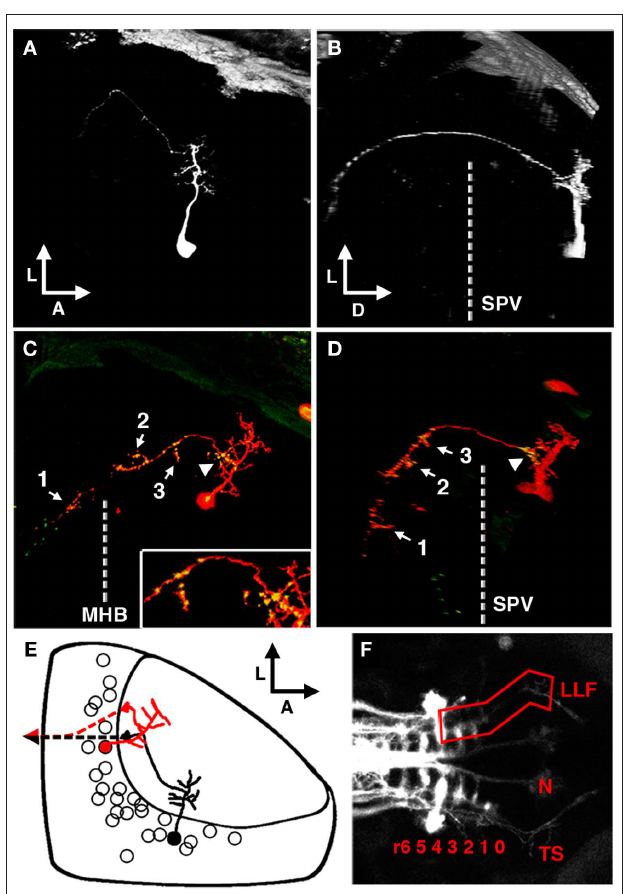
FiGure 8 | The periventricular projection neuron cell type. (A) Dorsal view of a two-photon image volume containing a single labeled PVPN imaged at 3 dpf. Note the short, sparse apical dendrite that gives rise to a single neurite that extends laterally toward the edge of the tectum. (B) Ninety degree rotation of image volume in (A) . The single long process has extended ventrally out of the tectum before redirecting to extend in a postero-medial orientation. Dashed line indicates the approximate ventral extent of the SPV. (C) Merged confocal image volume of a single 5 dpf nsPVIN expressing both dsRed (red) and Syp–GFP (green). Dashed line indicates approximate location of the midbrain–hindbrain boundary. Inset: 2 × magnification of region indicated by arrowhead. Note that bright Syp–GFP puncta are located in multiple regions: within the distal segment of the efferent process (arrow 1), the sparse network of collateral branches in the ventral midbrain (arrows 2–3), and a proximal segment within the tectal neuropil (arrowhead). (D) Ninety degree rotation of image volume in (C) . (e) Schematic depiction of PVPN cell body distribution throughout the SPV layer. Note that a majority of these cells are located in the shallow SPV close to the neuropil. Cell traced in black correspond to neuron in (A,B) . Note that the more medial cell body location necessitates an initial lateral trajectory in order to reach the edge of the tectal neuropil. In contrast, the cell in ( C,D ; traced in red) is located laterally, which permits a more direct exit from the tectal neuropil. Dashed line indicates descending axon trajectory after exiting the tectum. (F) Maximum projection of reticulospinal circuitry labeled by pressure injection of DiI into the spinal cord of a fixed larvae at 5 dpf. Boxed region indicates the synaptic field for PVPN efferent axons, which grow along the trajectory of the LLF, which runs from the torus TS, through the MO to the HB reticular formation (numbers indicate rhombomere position). Boxed region indicates the typical PVPN arborization field, which spans the TS, MO, and anterior hindbrain. Dashed line indicates midbrain–hindbrain boundary (MHB). Scale bar, 25 μm in (A–D) , 100 μm in (e)